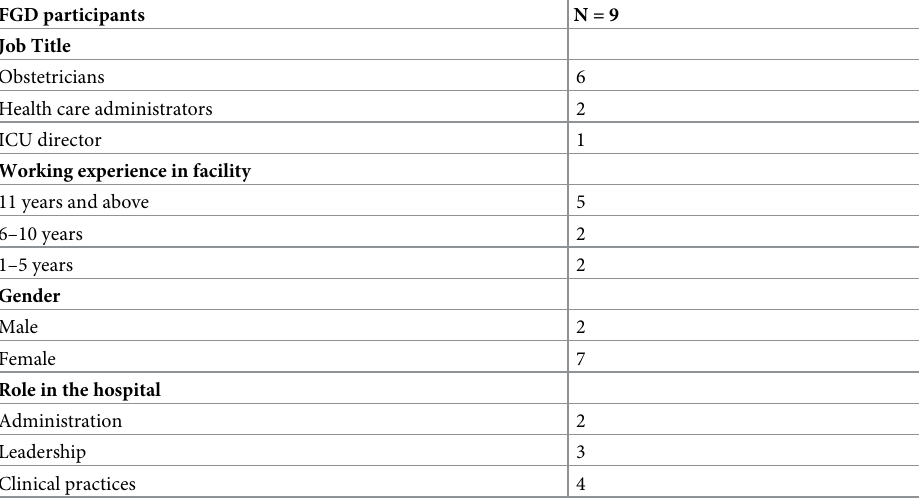
Table 4. FGD with faculties and administrators.